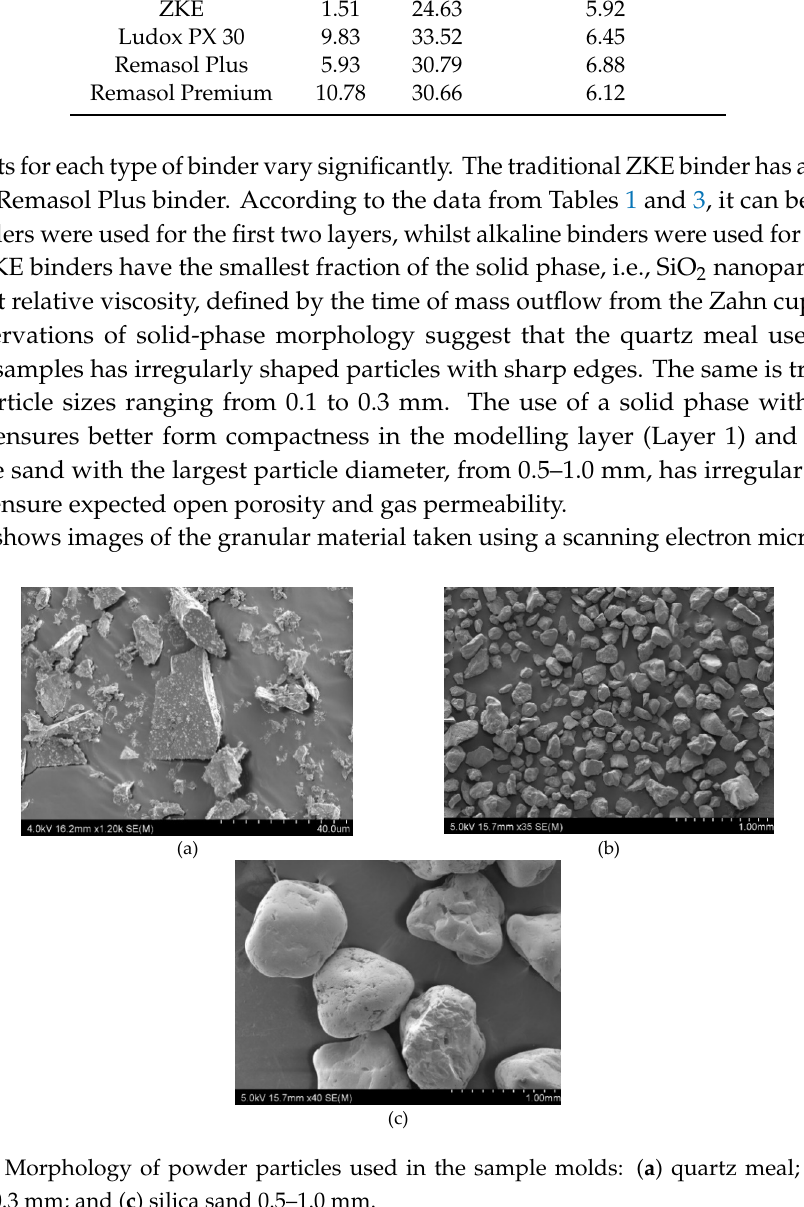
Table 3. Properties of polymeric binders.